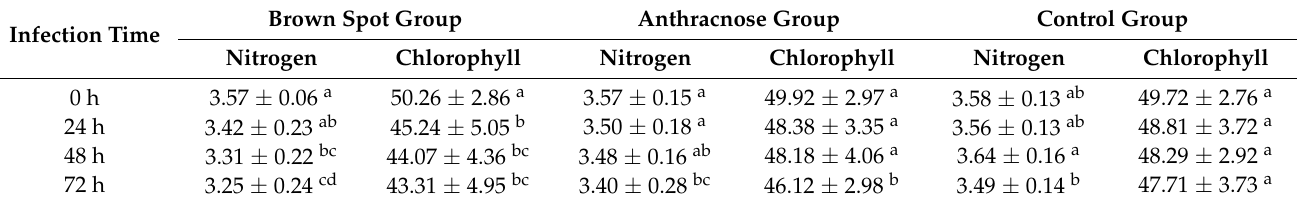
Table 1. Effects of fungal infection on mean and standard error of the nitrogen and chlorophyll content for the cucumber’s